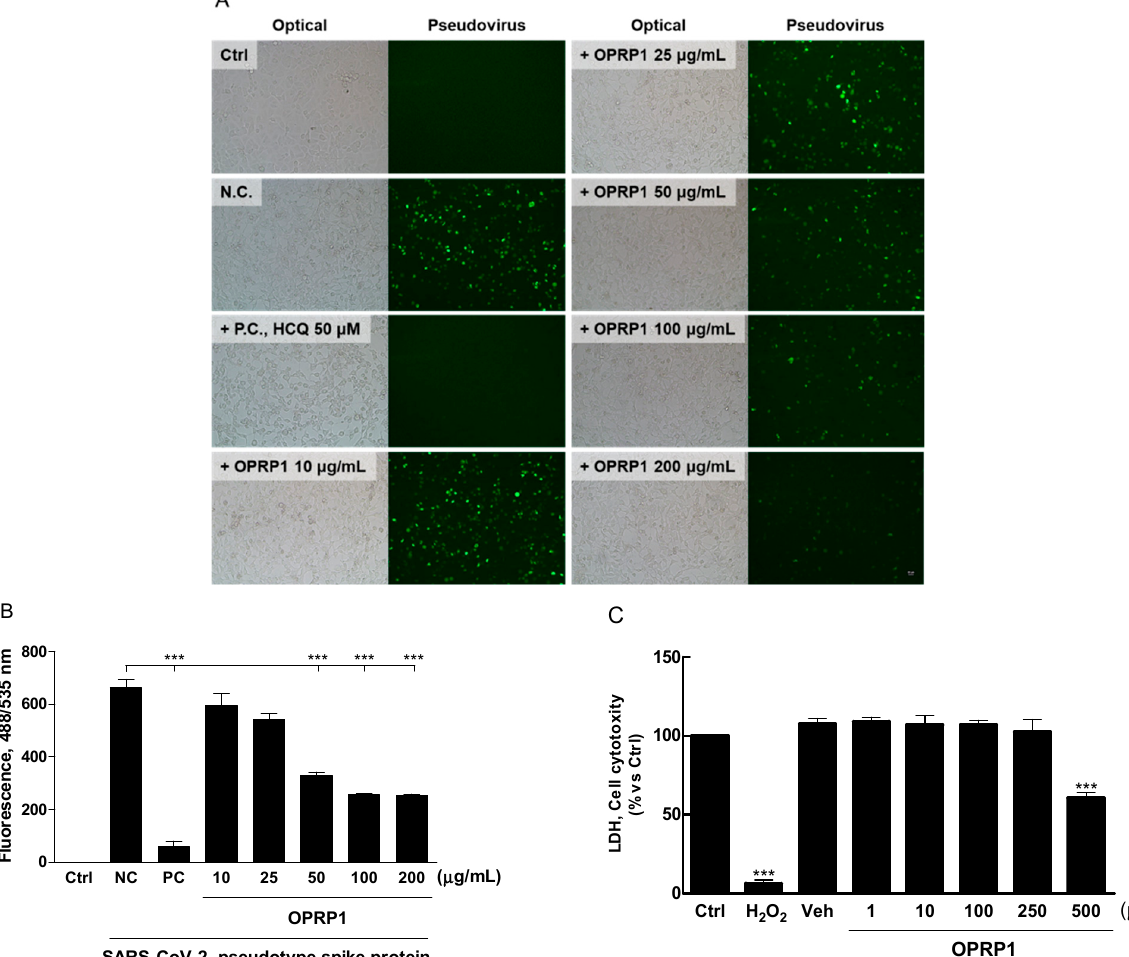
Figure 5. Inhibition of SARS-CoV-2 pseudovirus entry into hACE2 expressing host cells by OPRP1. Image captures of entry of pseudoviruses bearing SARS-CoV-2 spike protein (green fluorescent protein reporters; BacMam-based) in host cells (A549). Concentration-dependent inhibition of OPRP1 (10 to 200 μ g/mL) was assessed and statistically compared with normal control (free entry) and positive control (hydroxychloroquine, 50 μ M) from three separate experiments. ( A ) Representative images and ( B ) their quantification results for pseudovirus entry (green) were analyzed by using ImageJ and spectrophotometer, respectively. ( C ) LDH release in the presence of varying concentrations of OPRP (1, 10, 100, 250, 500 μ g/mL) in A549. *** p < 0.001 vs. NC.